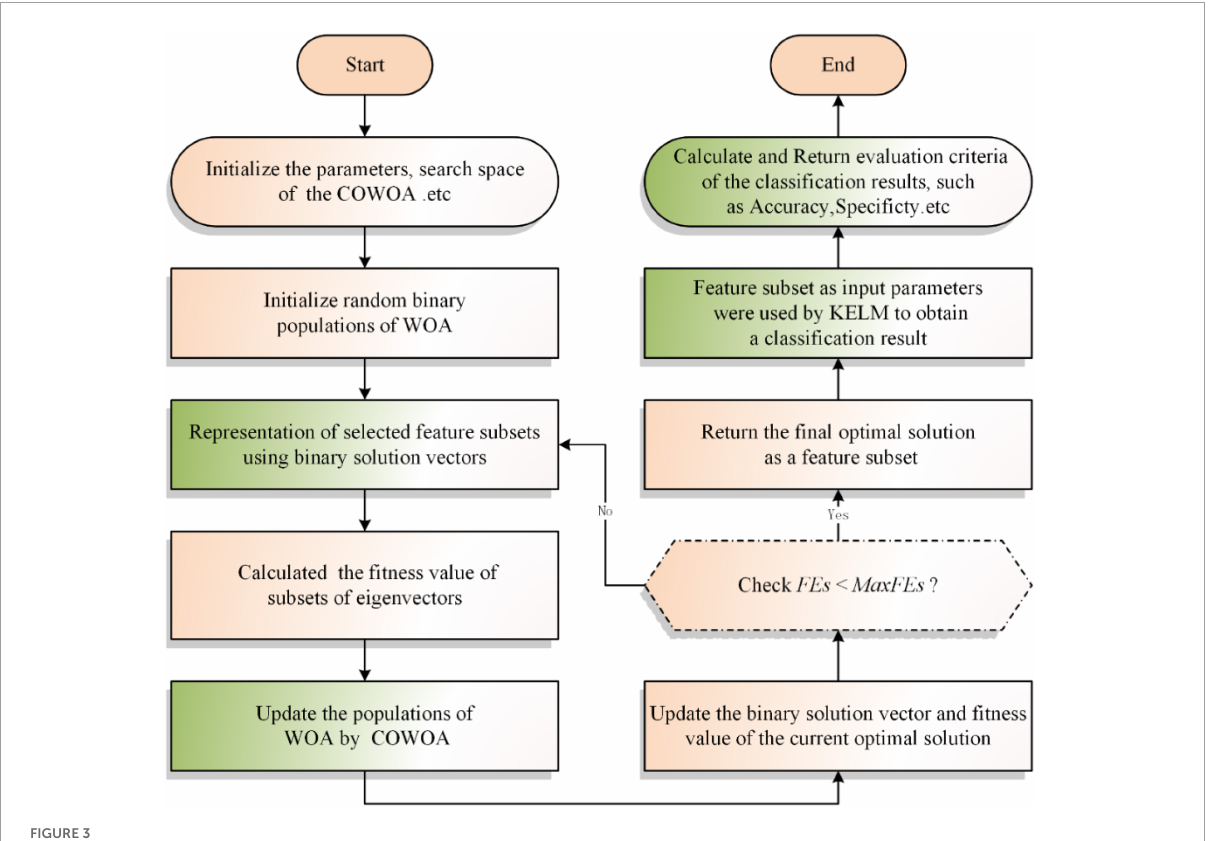
FIGURE3 Flowchart of the bCOWOA-KELM